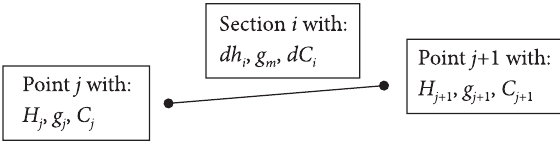
Fig. 3. Two levelling stations and a section between them with corresponding values of height, gravity and geopotential, the used symbols are explained in